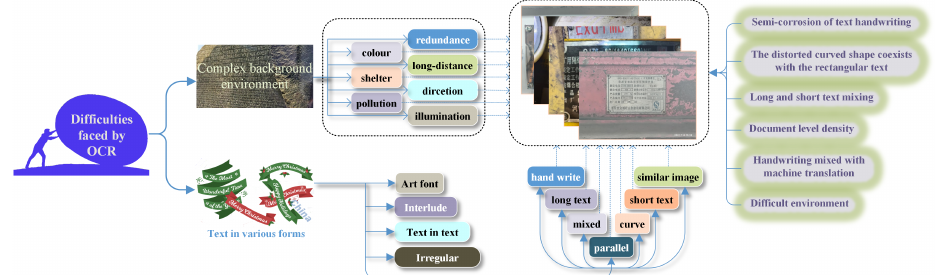
Figure 1. Challenges of OCR in industrial environments. Optical Character Recognition (OCR) faces several challenges in industrial settings. It includes the ability to recognize text in a variety of sizes, fonts, and orientations, as well as the capability to identify text in images that have low resolution and are affected by noise, such as those with multiple light sources or bright lighting. Nameplate image: mixed Chinese-English scene. Provides equipment specifications and performance information. These difficulties must be overcome to enable accurate and reliable text recognition in industrial